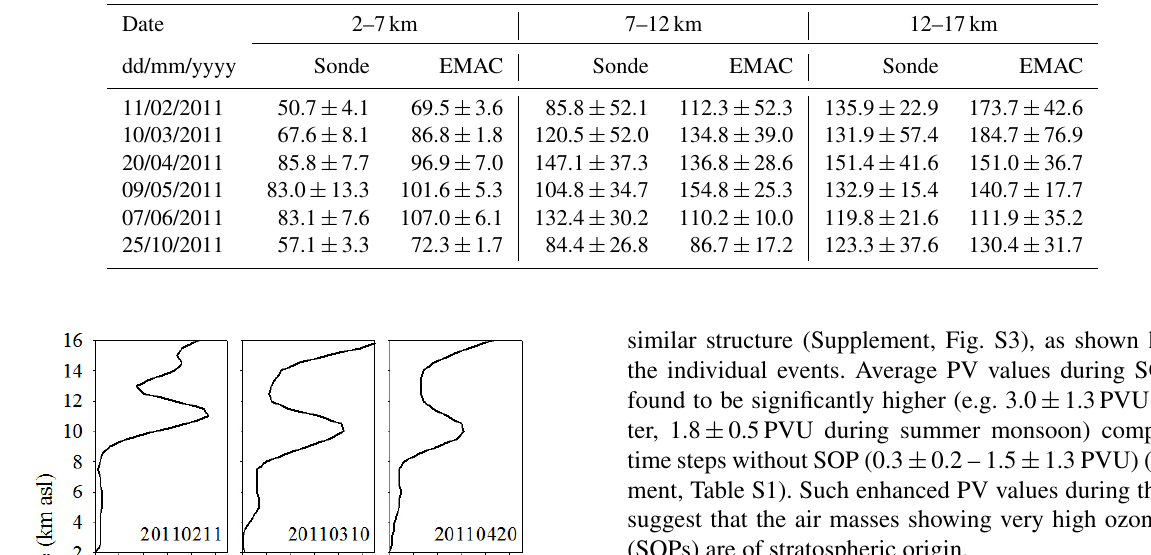
Table 1. A comparison of average ozone mixing ratios between ozone-sondes and EMAC model for the lower, middle and upper troposphere during the six SOP events over Nainital.